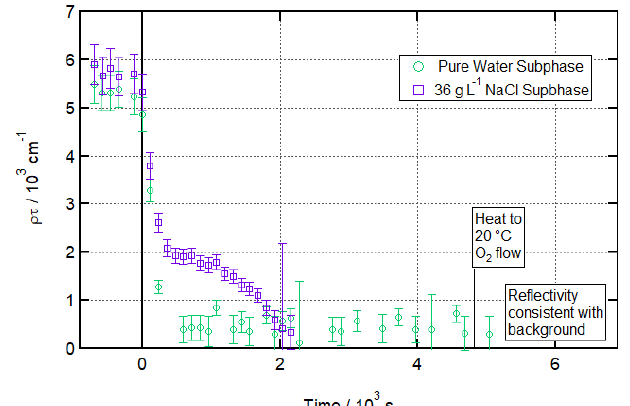
Figure 6. Ozonolysis of a partially deuterated oleic acid monolayer floating on pure vs. salt water. Time evolution plot for ozonolysis of 17µL 1.3gL − 1 d 18 -OA (CHCl 3 spreading solution) on pure water (green circles) and 36gL − 1 NaCl(aq) (purple squares) subphases by 323 ± 29ppb O 3 introduced at t = 0s at 3 ± 1 ◦ C (pure water) or − 2 ± 1 ◦ C (salt